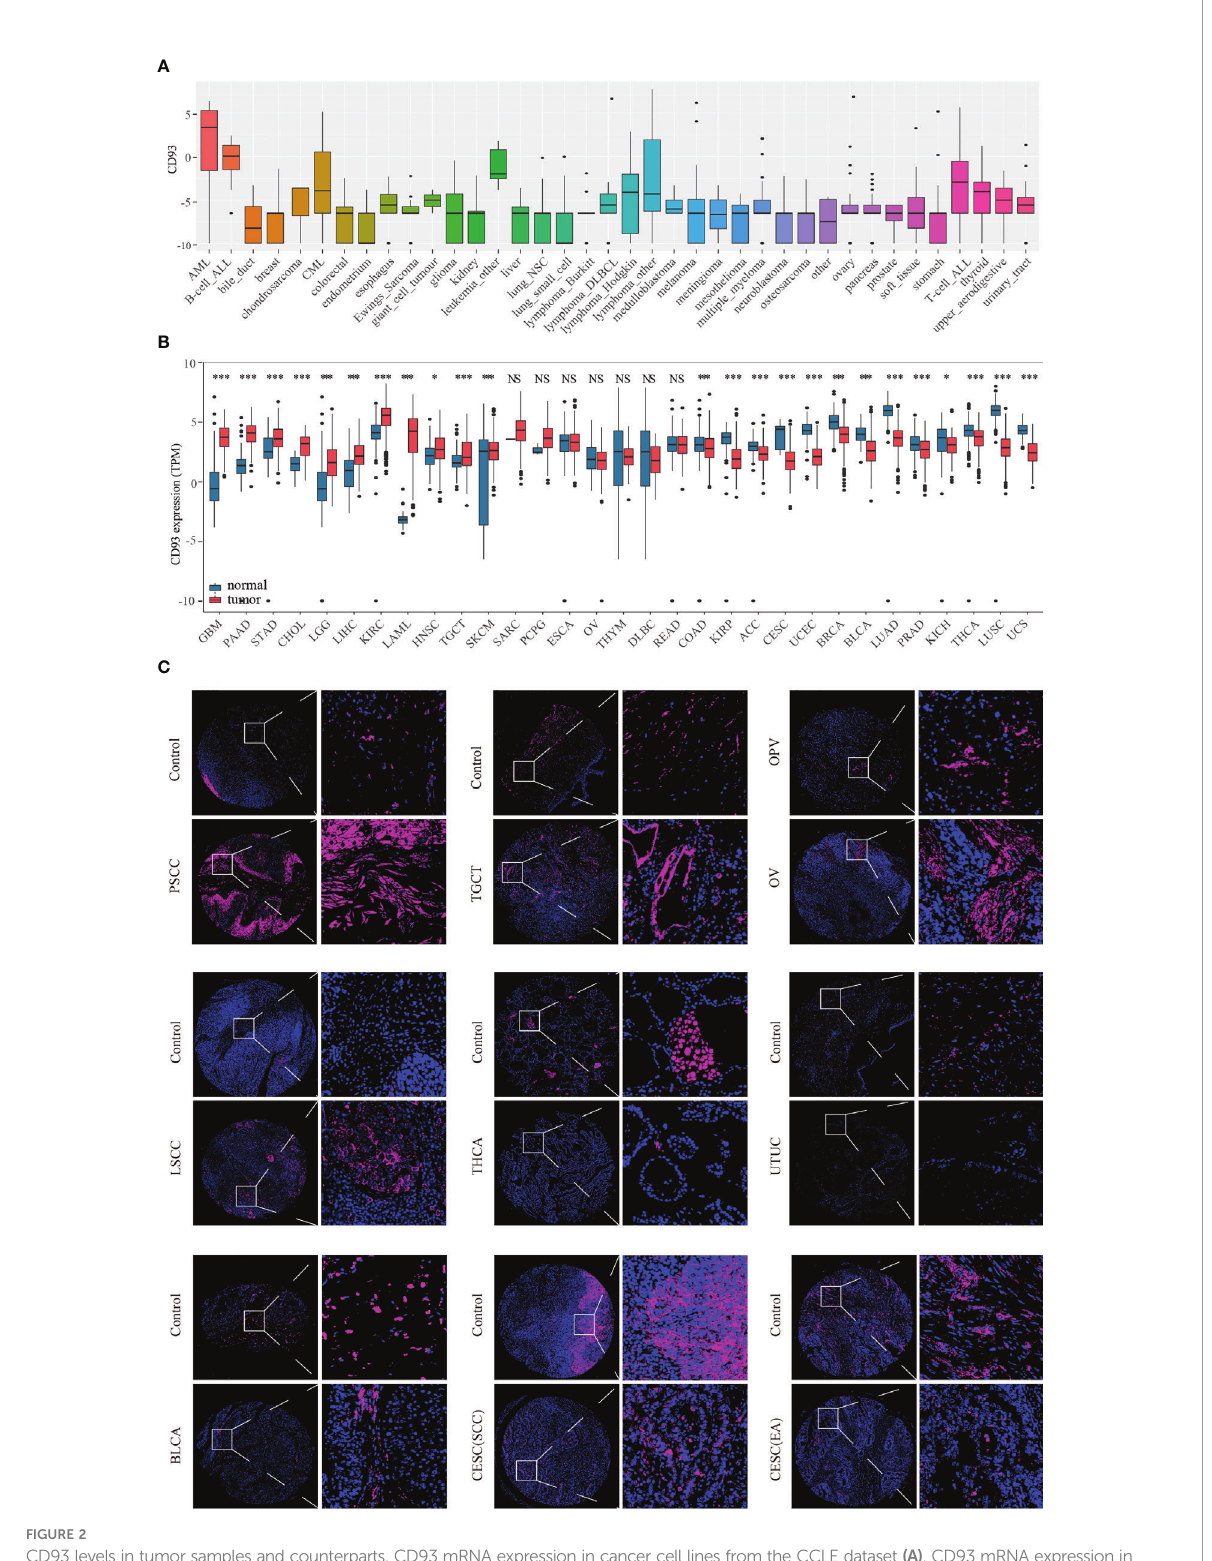
FIGURE 2 CD93 levels in tumor samples and counterparts. CD93 mRNA expression in cancer cell lines from the CCLE dataset (A) . CD93 mRNA expression in cancer and normal samples from the TCGA and GETX datasets (B) . CD93 protein expression in cancer and control samples in tumor microarrays (C) . *p < 0.05, ***p < 0.001, NS, no signi fi cant